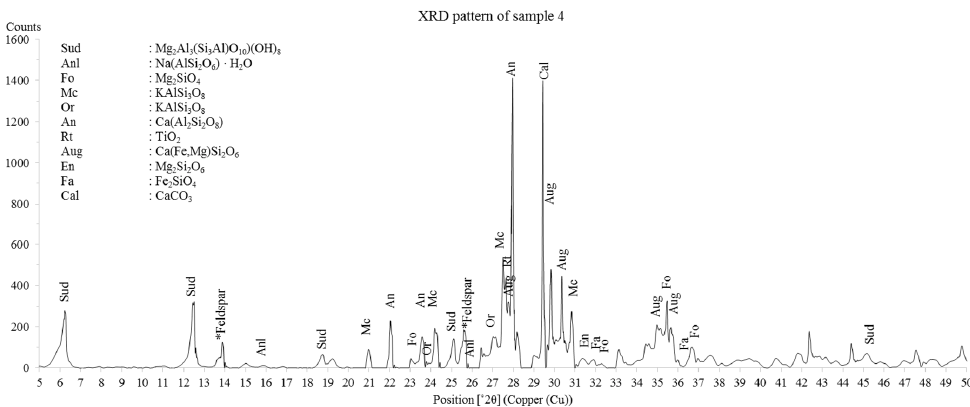
Figure 7. XRD analysis of sample 4 of the Segamat basalt (Chl: chlorite, Sud: sudoite, *Feldspar: common feldspar group peak, Anl: analcime, Afs: alkali feldspar, Mc: microcline, An: anorthite, Fo: forsterite, Or = : orthoclase, Rt: rutile, Aug: augite, Hyp: hypersthene, Cal: calcite, En: enstatite, Fa: